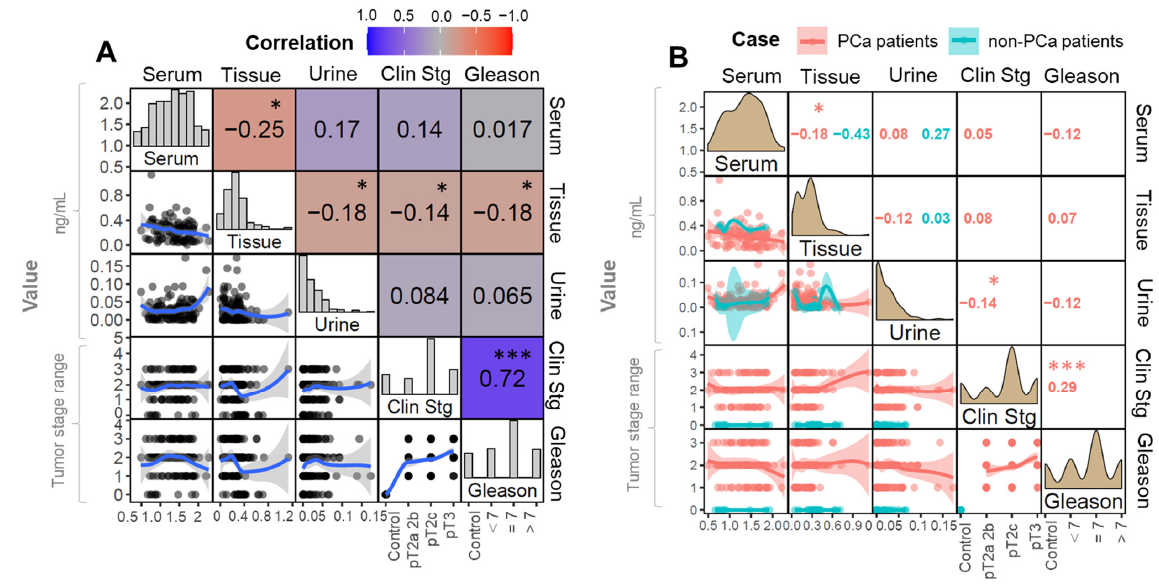
Figure 2. Plots showing the correlations between citric acid levels measured in the different biological matrices and their relationship with cancer staging (in terms of clinical stage and GS)—with the respective correlation coefficients calculated on the basis of ( A ) all cases or ( B ) separately, according to the study groups. Numerals inside the boxes refer to the Spearman coefficient (rho) found for the given bicorrelation. The symbols “***” and “*”, correspond to p < 0.001 and ≤ 0.05, respectively. Clin Stg = cancer clinical staging.